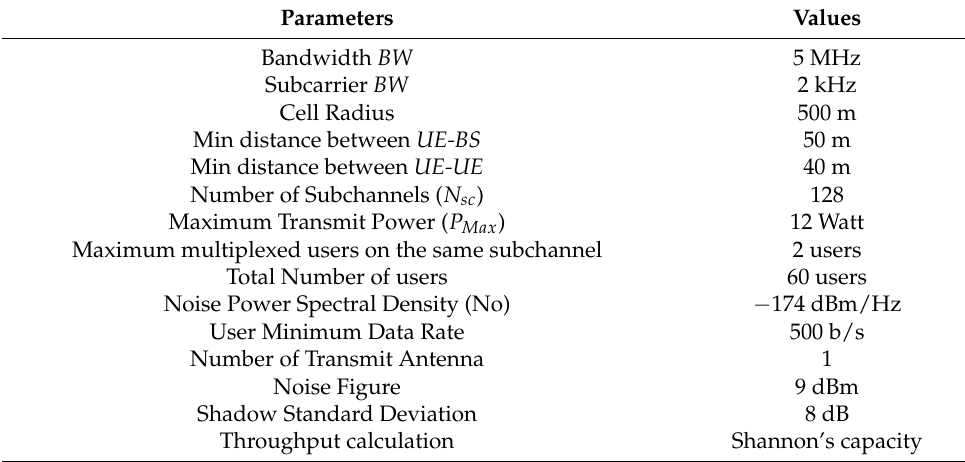
Table 2. System Design